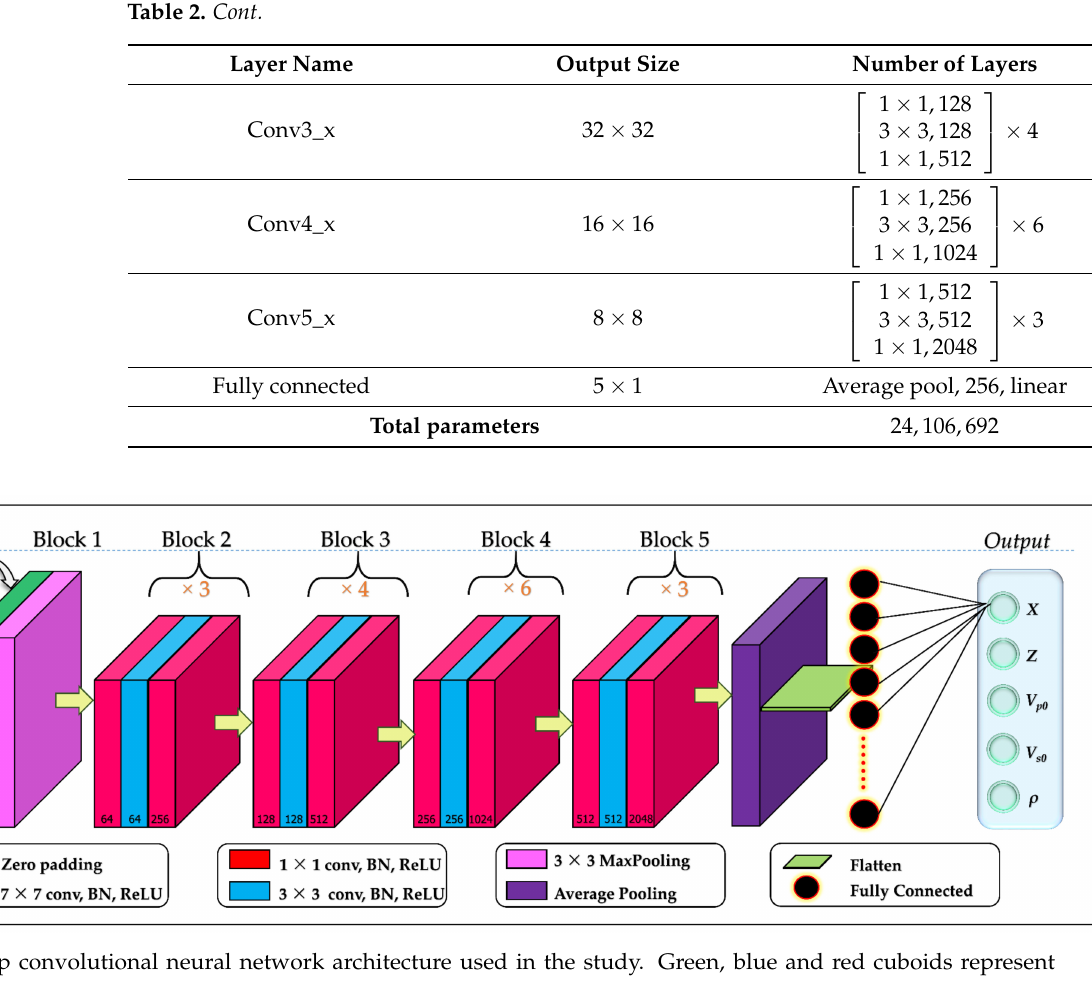
Figure 4. Deep convolutional neural network architecture used in the study. Green, blue and red cuboids represent multi-channel feature maps with number of channels shown at the bottom of the cuboids. The input dimensions of each layer is given in Table